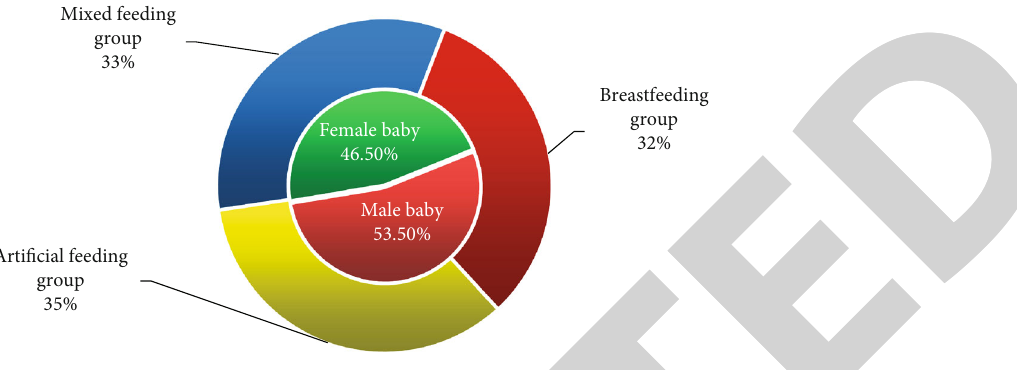
Figure 1: Analysis of basic data of infants and young